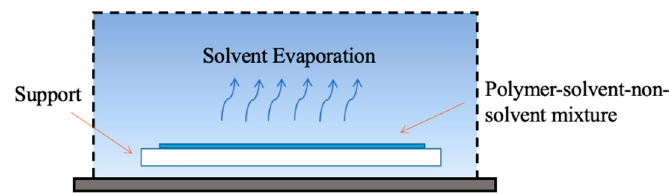
Figure 19. Process for EIPS method.